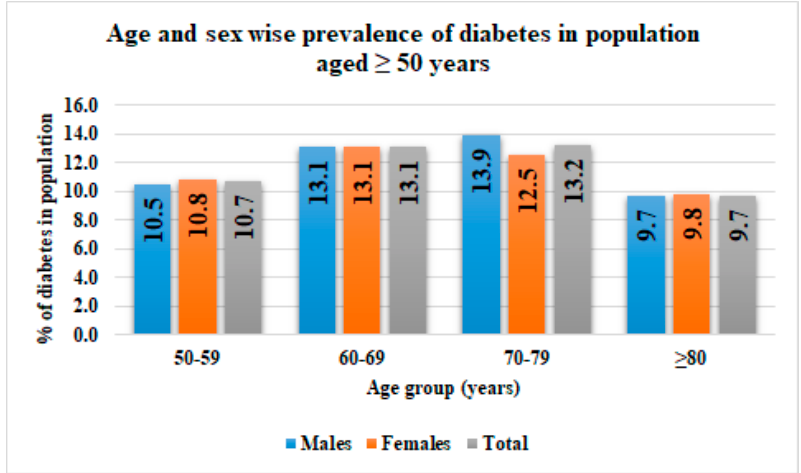
Figure 1. Age–wise and sex–wise prevalence of diabetes in the population aged ≥ 50 years.